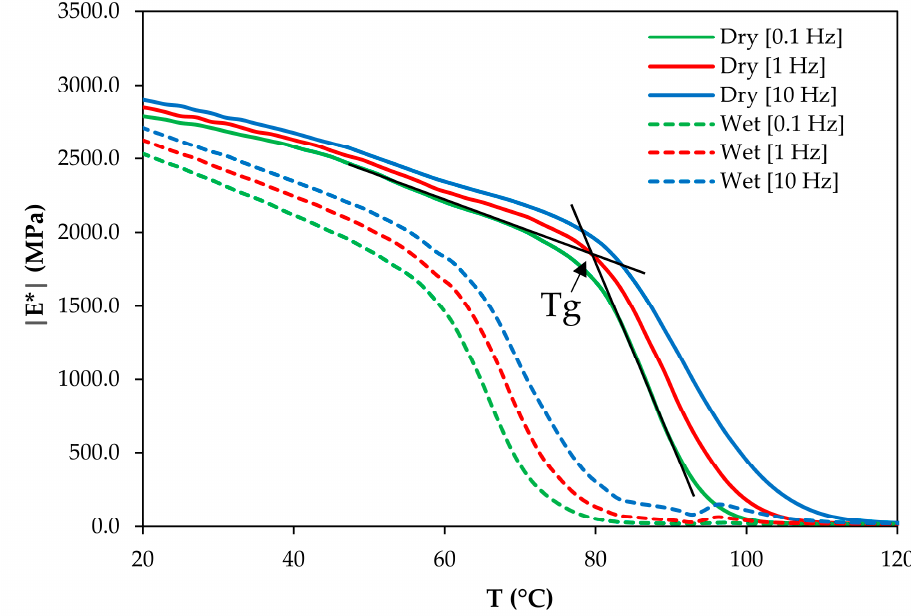
Figure 7. Complex storage moduli of dry and saturated epoxy samples at various testing frequencies (0.1, 1, and 10 Hz). An example of T g determination is indicated with black lines and an arrow.